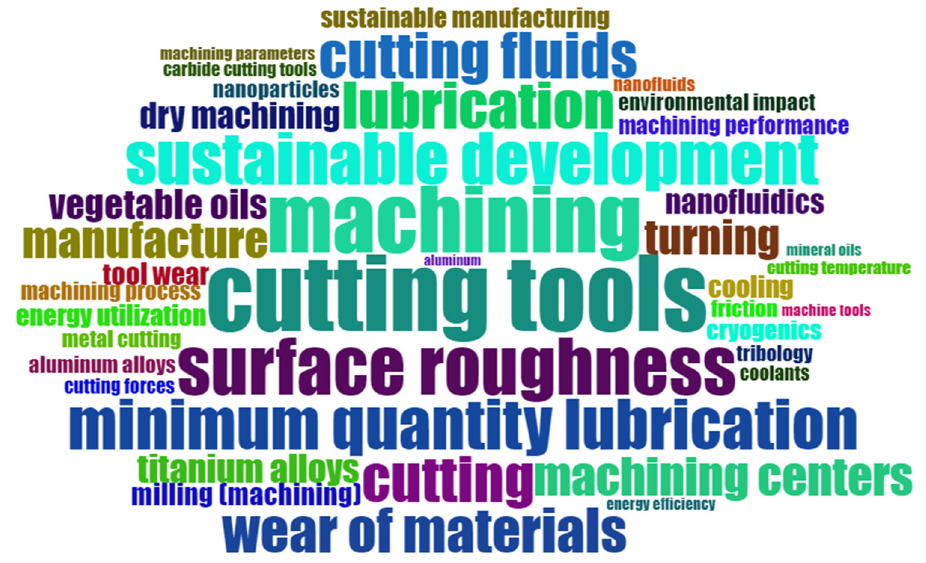
Figure 3. Pictorial representation of the most frequently used keywords.